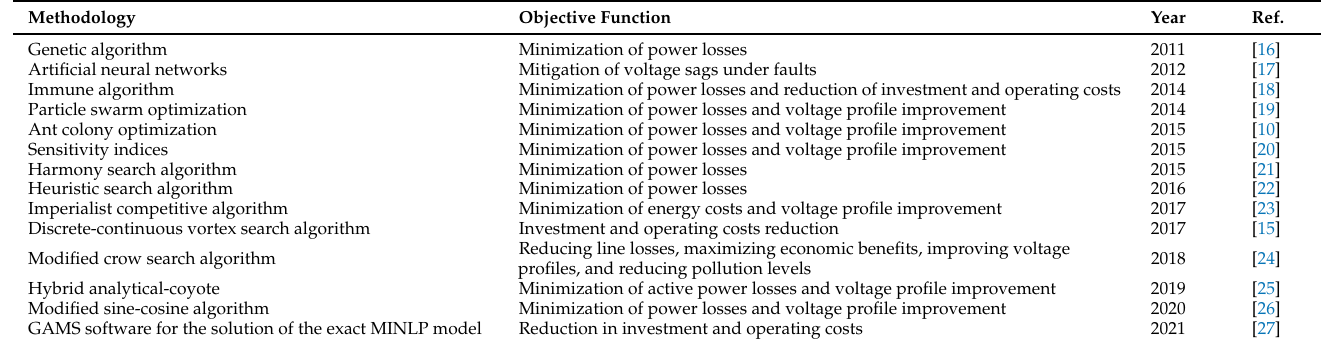
Table 1. Summary of research works related to the siting and sizing of